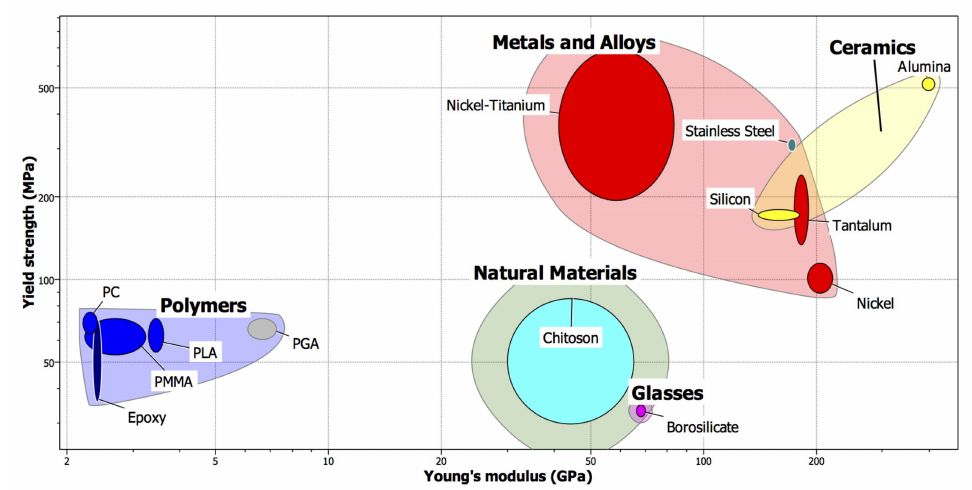
Figure 10. Yield strength vs. Young’s modulus of different materials used for the fabrication of MNs. Plastics: PC, Epoxy, PMMA, PGA, PLA. Metals and alloys: nickel, stainless steel, tanta- lum, and nickel–titanium. Ceramics: alumina and silicon. Chitison and Borosilicate glass [99]. Reprinted (adapted) with permission from (Cahill, Ellen M., and Eoin D. O’Cearbhaill.